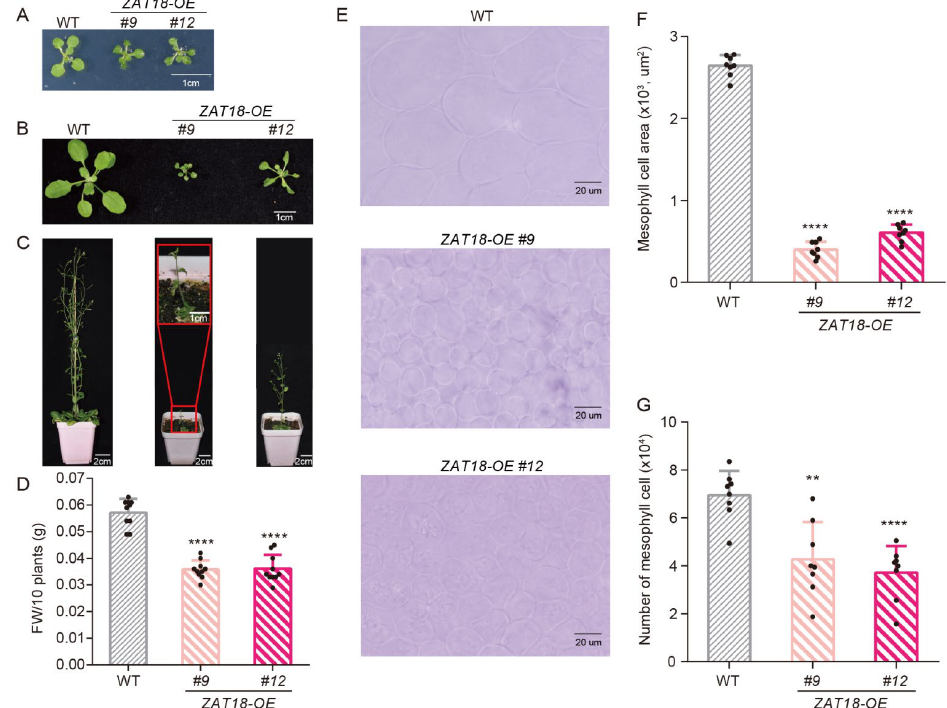
Figure 4. ZAT18 overexpression resulted in growth inhibition. ( A–C ) Representative plants of ten-day-old ( A ), three-week-old ( B ) and eight-week-old ( C ) WT and ZAT18-OE lines. ( D ) Ten-day-old WT and ZAT18-OE seedlings were collected and weighed. n = 10, n indicates the number of biological replicates. ( E ) Mesophyll cells of the WT and ZAT18-OE lines were observed from a paradermal view. The fifth and sixth true leaves from the three-week-old plants were collected, fixed and cleared for microscopic analysis. Bar: 20 µ m. ( F ) The areas of mesophyll cells in ( E ) were measured using ImageJ. n = 8, n indicates the number of biological replicates. ( G ) The numbers of mesophyll cells per leaf were determined via dividing the leaf size by the average cell area of the corresponding leaf. n = 8,